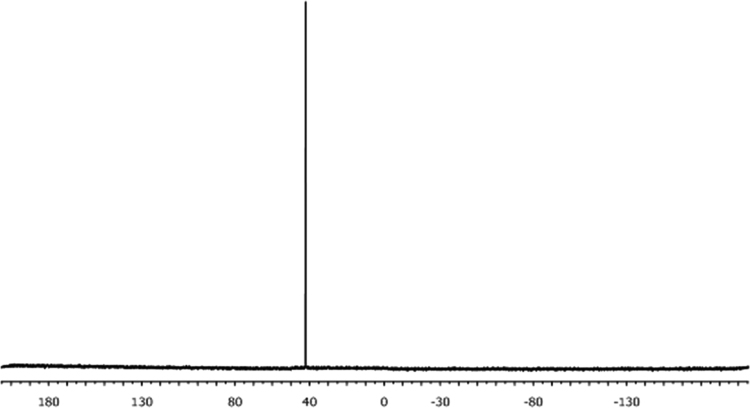
31P NMR of diphenylphosphinothious acid, C6H5SPPh2, 2.